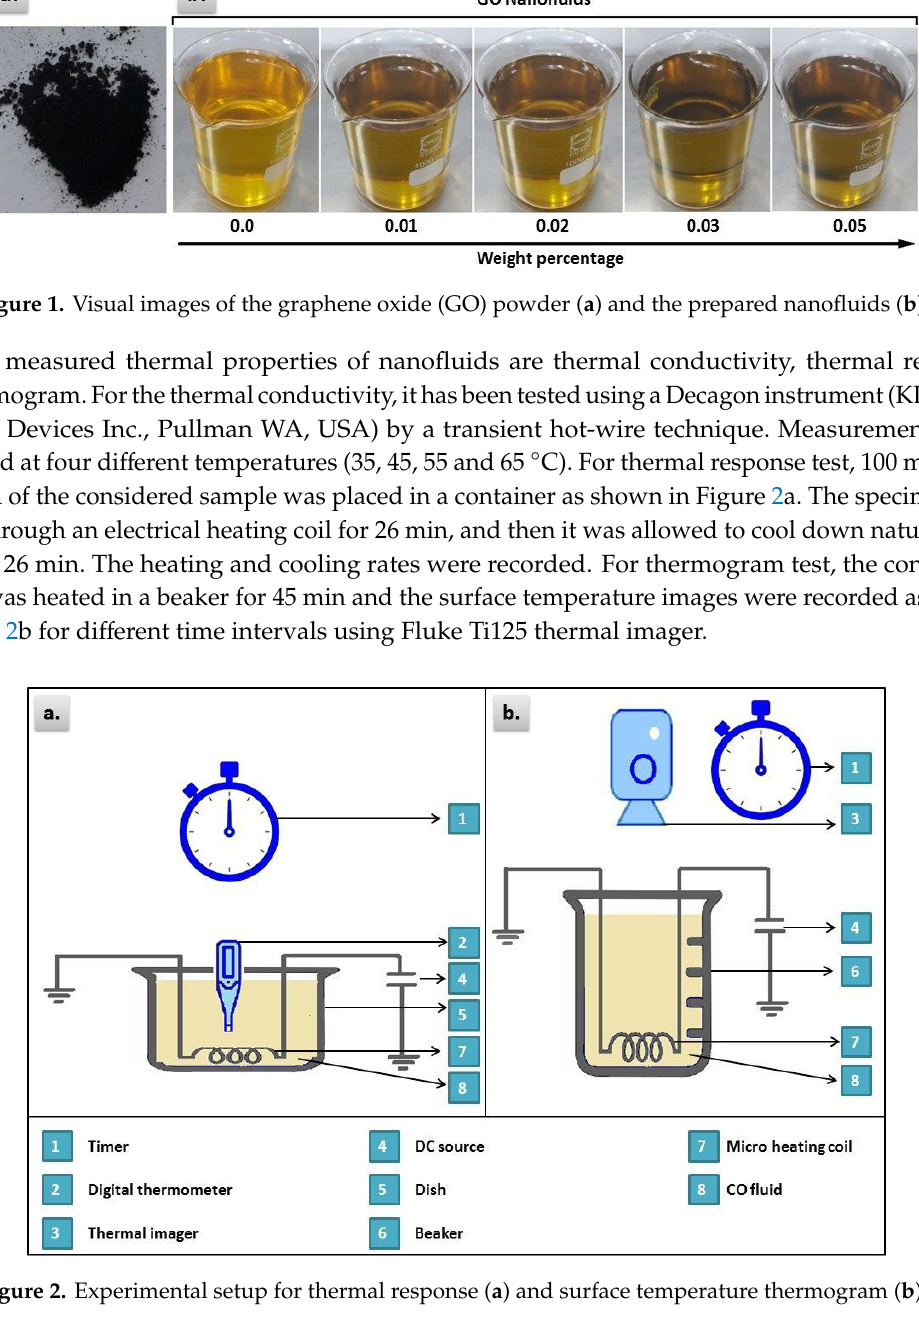
Figure 2. Experimental setup for thermal response ( a ) and surface temperature thermogram ( b ).